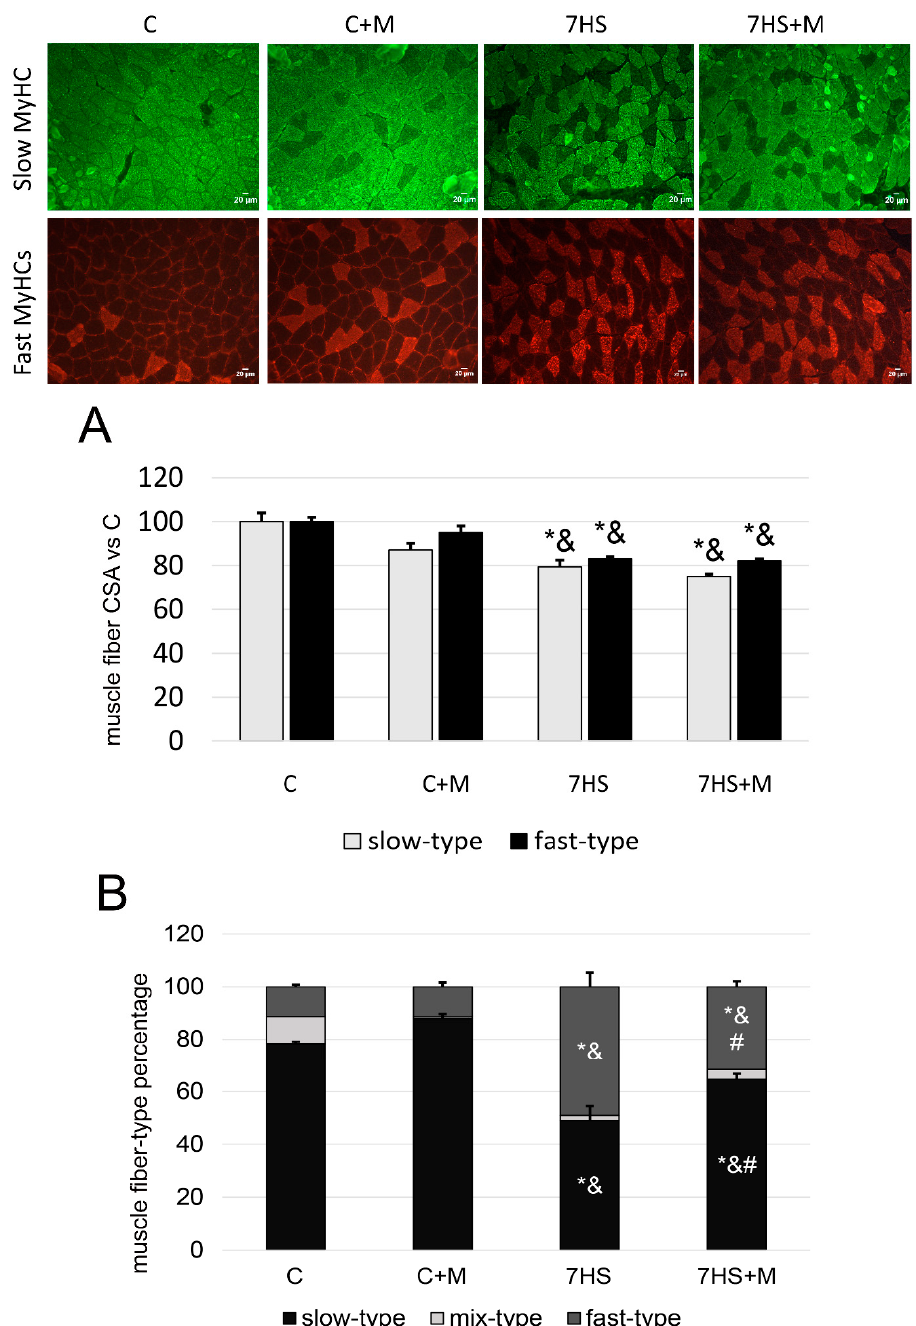
Figure 4. Immunohistochemical analysis of slow-type and fast-type myofiber relative percentage vs. control, arbitrarily set at 100% ( A ), and fibers’ CSA ( B ) in the control group (C), control group with metformin (C+M), 7-day hindlimb-suspended group (7HS), and 7-day hindlimb-suspended group with metformin (7HS+M). Data are shown as % of the control group, and mean value of the C group has been arbitrarily set to 100%. *—significant difference from the control group. &—significant difference from C+M group. #—significant difference from 7HS group ( p < 0.05). Graphs represent mean value ± SEM; n = 8/group.